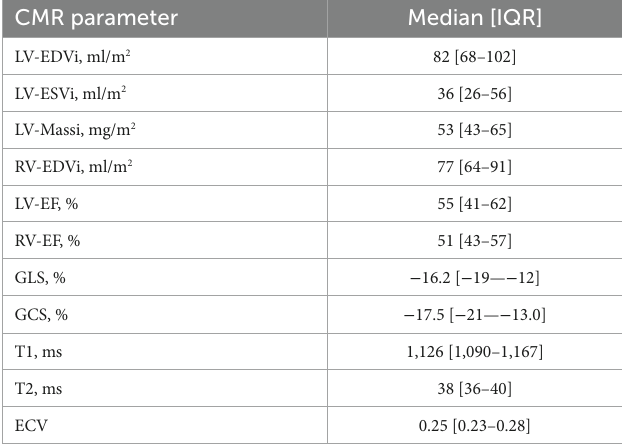
TABLE 2 Baseline CMR parameters.